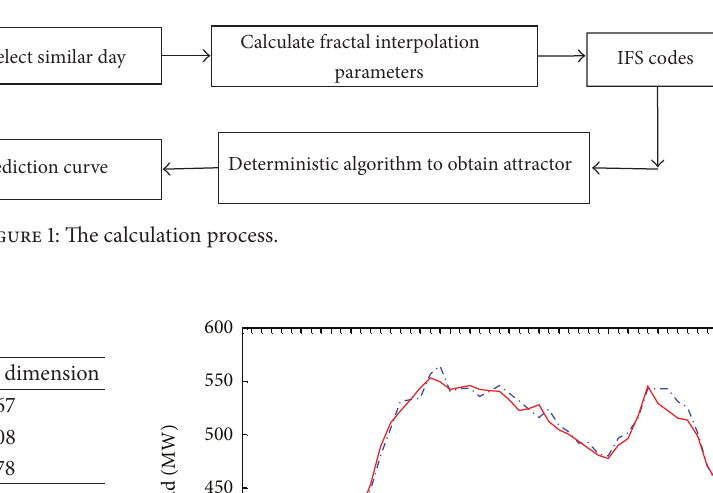
Algorithm 1: Deterministic algorithm of seeking attractor.